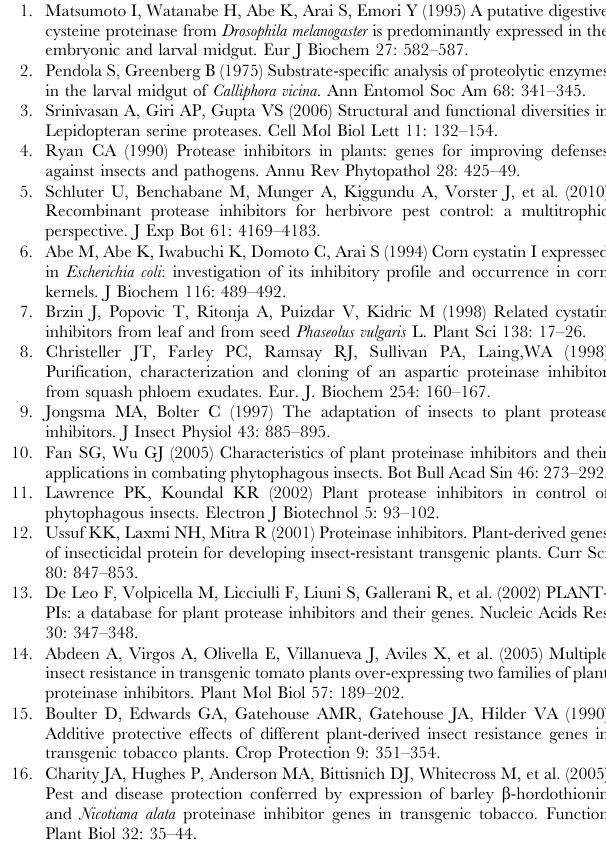
resistant to the sugar beet serine proteinase inhibitor. Further Table 5. Weights of tobacco budworm feeding on leaves